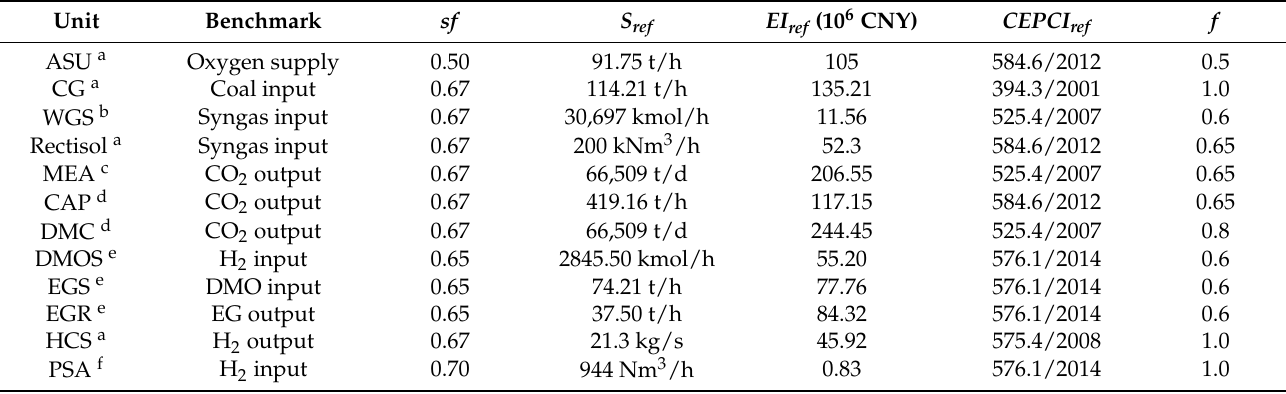
Table 5. Reference equipment investment of each unit.